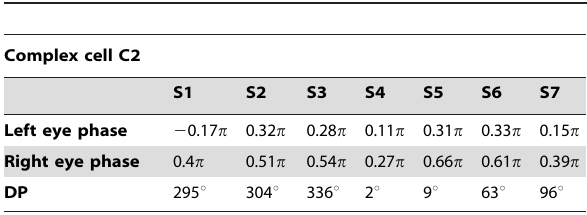
Table 2. Modeled simple cell 1D RF profile phases for complex cell